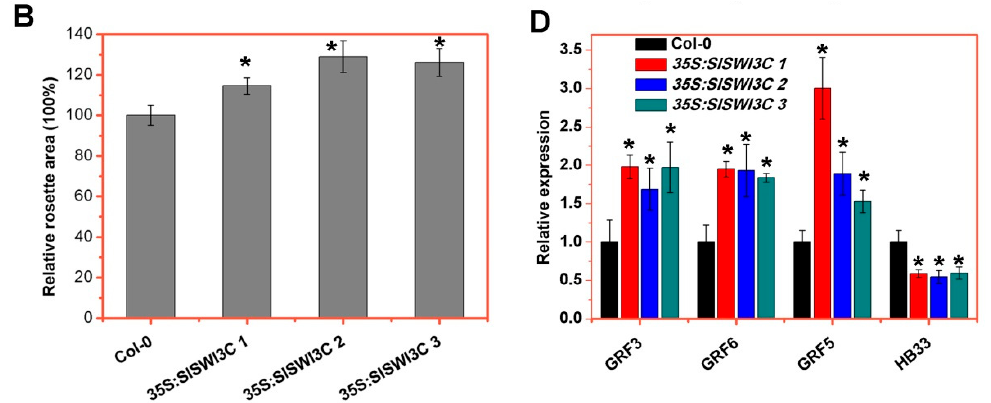
Figure 5. Overexpression of SlSWI3C enhances leaf growth. ( A ) Rosettes of 21-d-old Col-0 and 35S:SlSWI3C lines showing enhanced leaf growth. Three experiments were repeated with similar results, and one representative result was shown. Bar = 0.5 cm. ( B , C ) Total ( B ) and 5 th rosette ( C ) area calculated using ImageJ (http://rsb.info.nih.gov/ij/) software. The individual leaf from 21-d-old Col-0 and 35S:SlSWI3Cs plants was photographed and calculated using ImageJ. Error bars are SE ( n = 15). Asterisks indicate significant difference from the Col-0 ( p < 0.05, Student’s t test). The data are representative from three independent experiments. ( D ) SlSWI3C promotes the expression of GRFs in Arabidopsis . Expression levels determined by qRT-PCR in 21-d-old Col-0 and 35S:SlSWI3Cs rosettes grown in long-day (16 h light/8 h dark) conditions. qRT-PCR was amplified using gene-specific primers. The ACTIN2 ( AT3G18780 ) was used as an internal control. Error bars are SE. Asterisks indicate significant difference from wild-type plants ( p < 0.05, Student’s t test). The data are representative from three independent experiments.